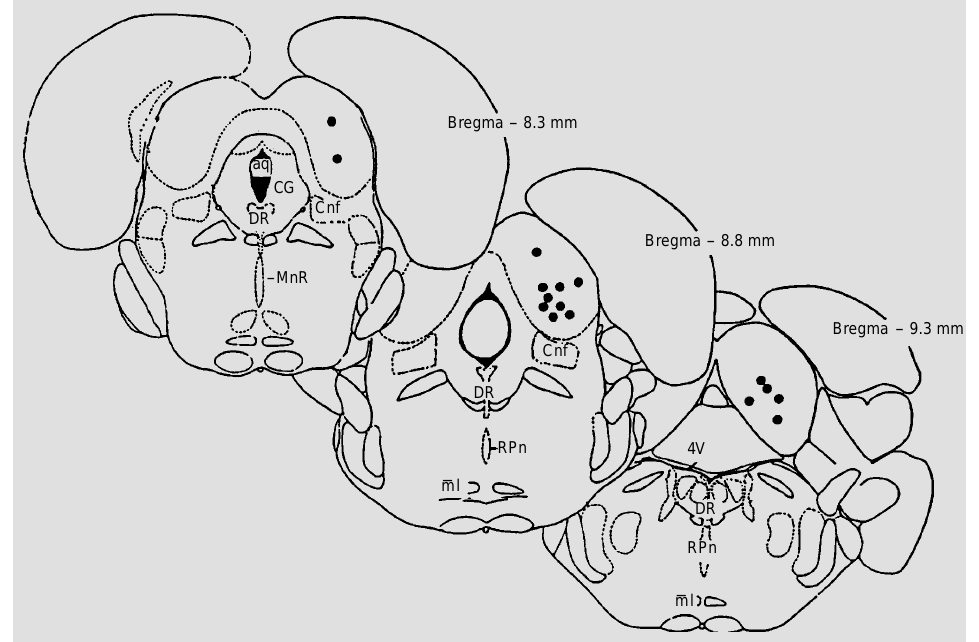
Figure 1 - Location of sites on cross-sections from the rat brain atlas of Paxinos and Watson (12). Figures represent the atlas coor- dinates in millimeters posterior to the bregma. Black circles indi- cate the inferior colliculus sites where electrical stimulation was applied. aq = Aqueduct; CG = central gray; DR = dorsal raphe nucleus; Cnf = cuneiform nu- cleus; ml = medial lemniscus; MnR = median raphe nucleus; 4V = fourth ventricle; RPn = raphe pontis